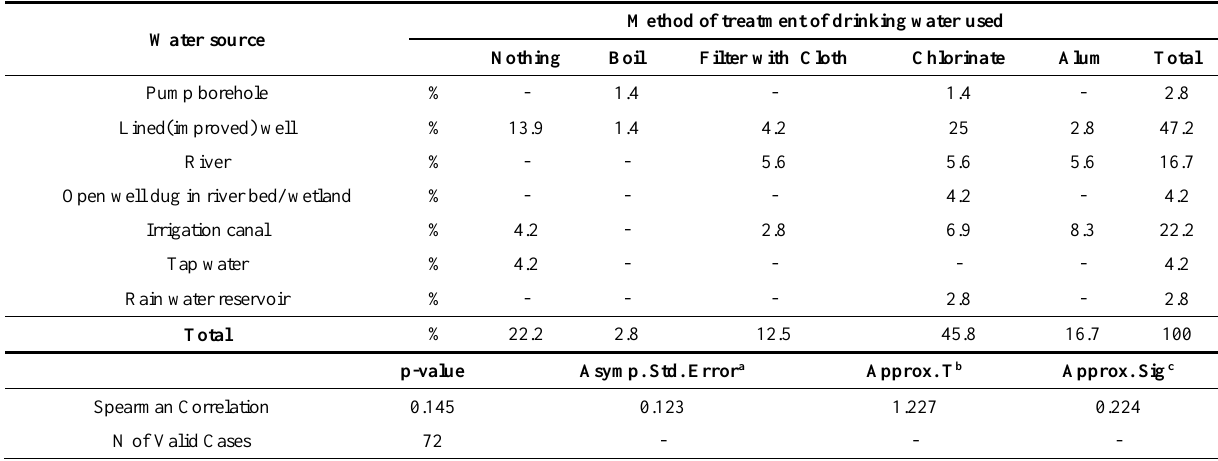
Table 4. Cross-tabulation of water source and method of drinking water